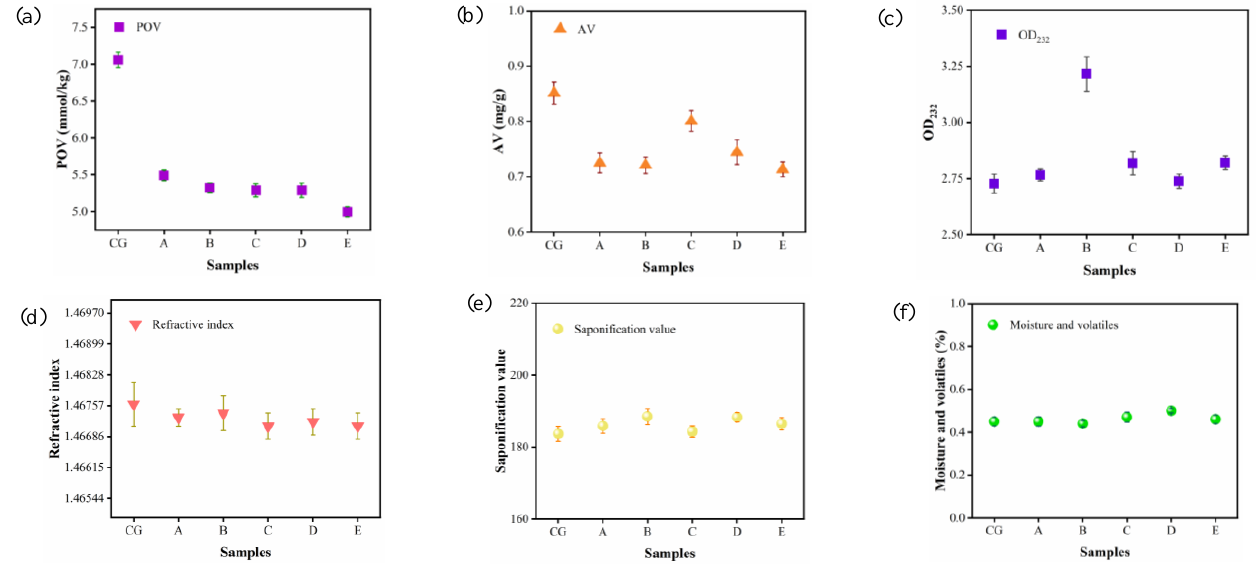
Figure 5. Effect of ceramic membrane degumming on peroxide value ( a ), acid value ( b ), UV absorbance ( c ), refractive index ( d ), saponification value ( e ), and moisture content of camellia oil ( f ). (CG) CVO; (A) 200 nm; (B) 140 nm; (C) 20 nm; (D)15 nm; (E) 10 nm.